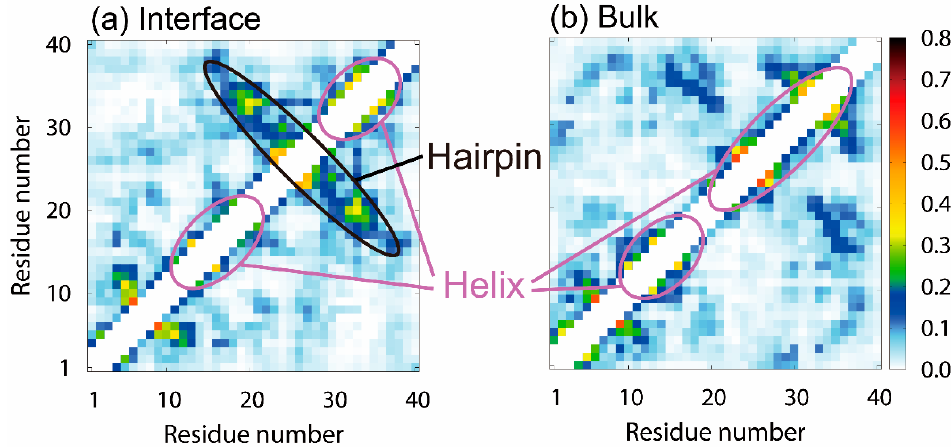
Figure 5. Intramolecular contact probabilities of the C α atoms of A β 40 ( a ) at the air–water interface and ( b ) in the bulk water. Reprinted with permission from Ref. [30]. Copyright 2019 American Chemical Society.